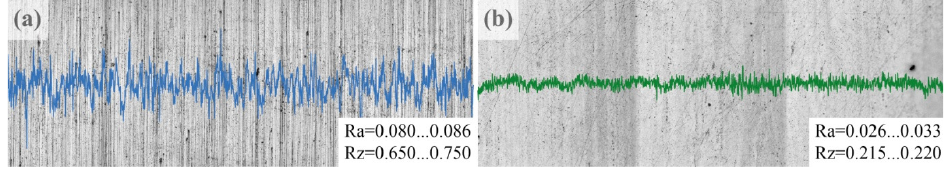
Figure 3. The surface appearance and the corresponding profiles after grinding ( a ) and polishing ( b ); roughness parameters are shown in the insets.